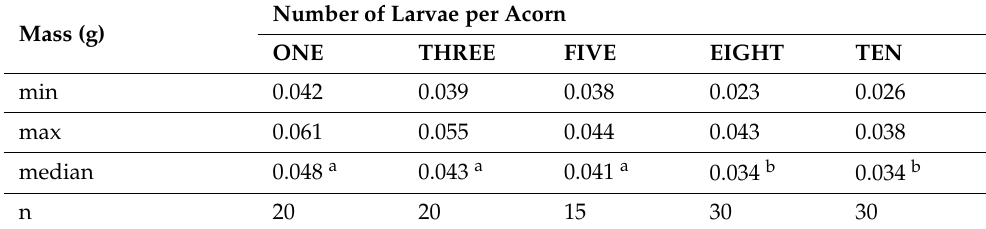
Table 2. Larval body mass (in grams) in acorns with experimental acorns with different numbers of larvae.